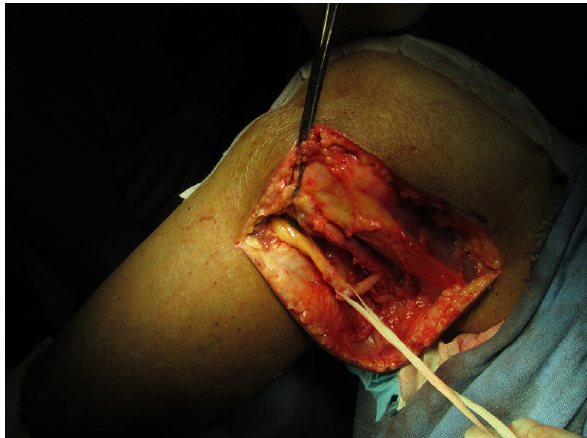
Figure 6. Decompression of the common peroneal nerve at the level of deep peroneal muscles after decompression of the cyst.